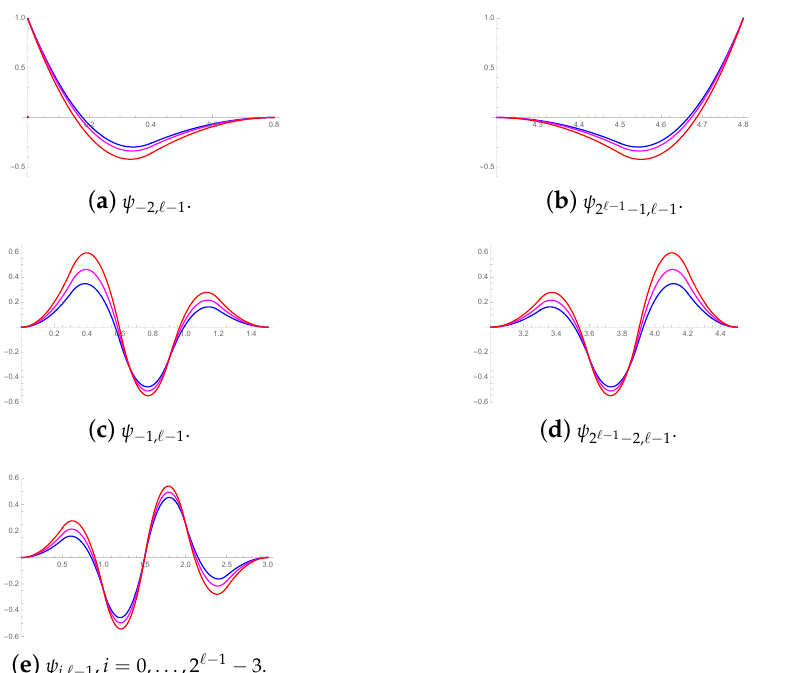
Figure 5. Graphs of Generalized B-spline wavelets for u 0 = 0.7 (Blue line), u 0 = 1 (Magenta line) and u 0 = 1.32 (Red